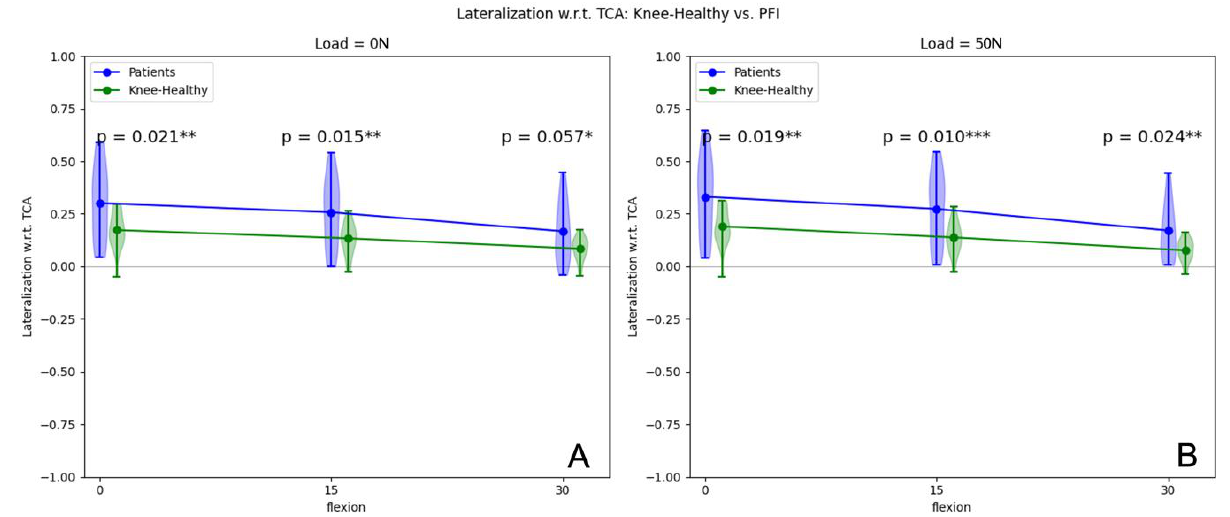
Figure 5. Patellar shift (mm) in unloaded ( A ) and loaded (50 N) situations ( B ) of patients and unteers from 0° to 30° flexion . * p -values < 0.01, ** p -values < 0.05, *** p -values < 0.01. volunteers from 0 ◦ to 30 ◦ flexion. * p -values < 0.01, ** p -values < 0.05, *** p -values < 0.01.